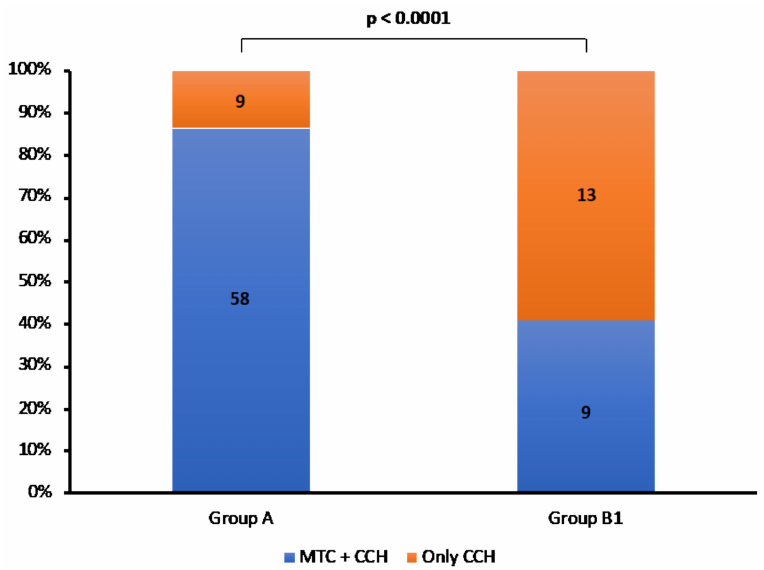
Figure 3. Rate of MTC + CCH and only CCH in Group A and B1